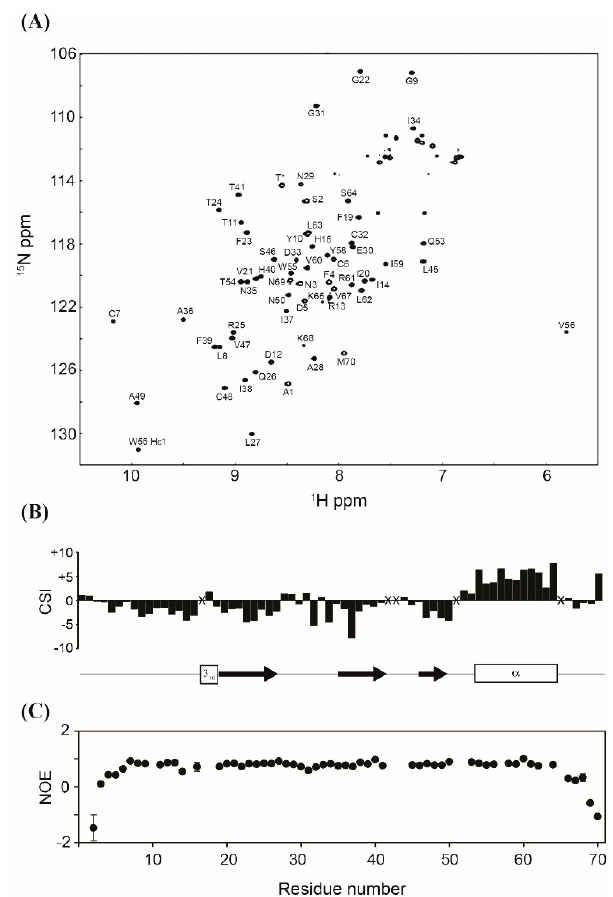
Figure 5. ( A ) Assigned 1 H, 15 N-HSQC NMR spectrum of MIP-3 α . The signal marked with T* originates from the extra Thr residue in the cloning artefact. ( B ) Secondary shifts were calculated as the added differences between the observed and the random coil chemical shifts of the C α and C ′ atoms, and they are plotted as a function of the residue number. The positions of the secondary structure in the previously reported structure of MIP-3 α (PDB code: 2jyo) are also shown. ( C ) 1 H, 15 N-heteronuclear NOE values are plotted as a function of residue number. X indicates that assignments were not available.